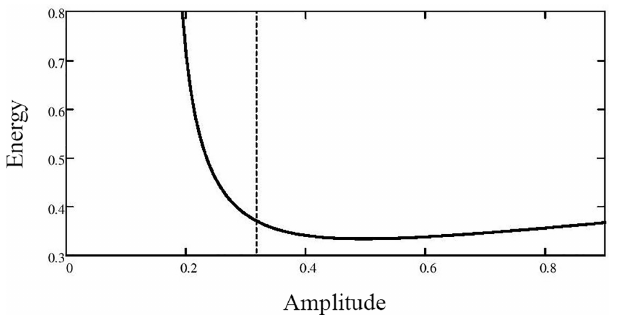
Figure 8. Energy versus wave amplitude. The dotted line corre- sponds to A 0 = A ∗